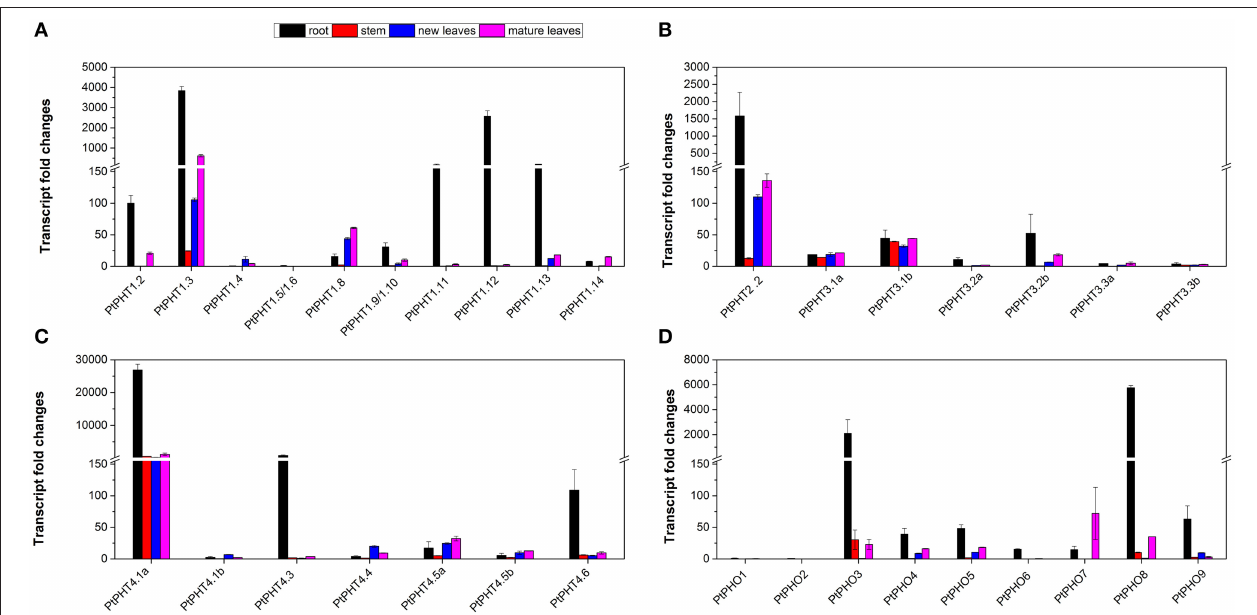
FIGURE 5 | The expression of PtPHT genes (A: PHT1; B: PHT2 and PHT3; C: PHT4; D: PHO) in different tissues of Populus simonii . Total RNA was isolated using a plant RNA extraction kit (R6827, Omega Bio-Tek, GA, USA) according to the manufacturer’s instructions. The relative expression of PHT1.2 was set as a standard (100). The RNA was used for qRT-PCR with PHT -specific primers. The signal intensities were calibrated based on a constitutively expressed poplar actin gene (Brunner et al., 2004b). The data are presented as the mean ± SD of three separate